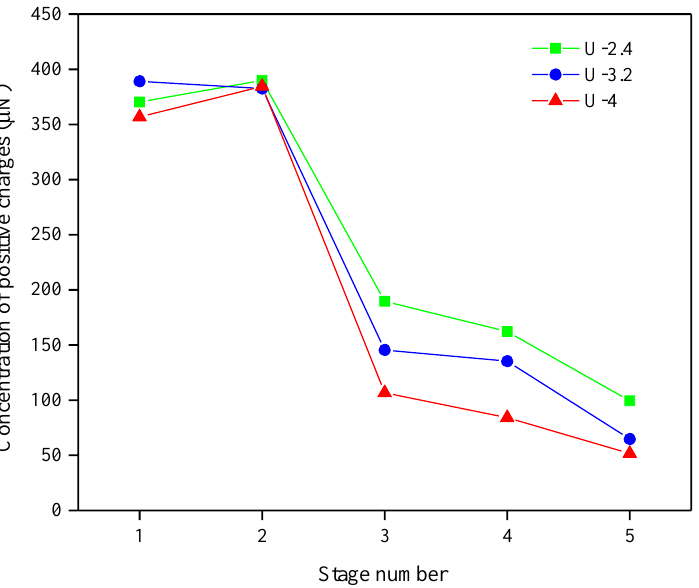
Figure 1. Concentration of positive charges ( µ N) as a function of the components added to the sus- pension.